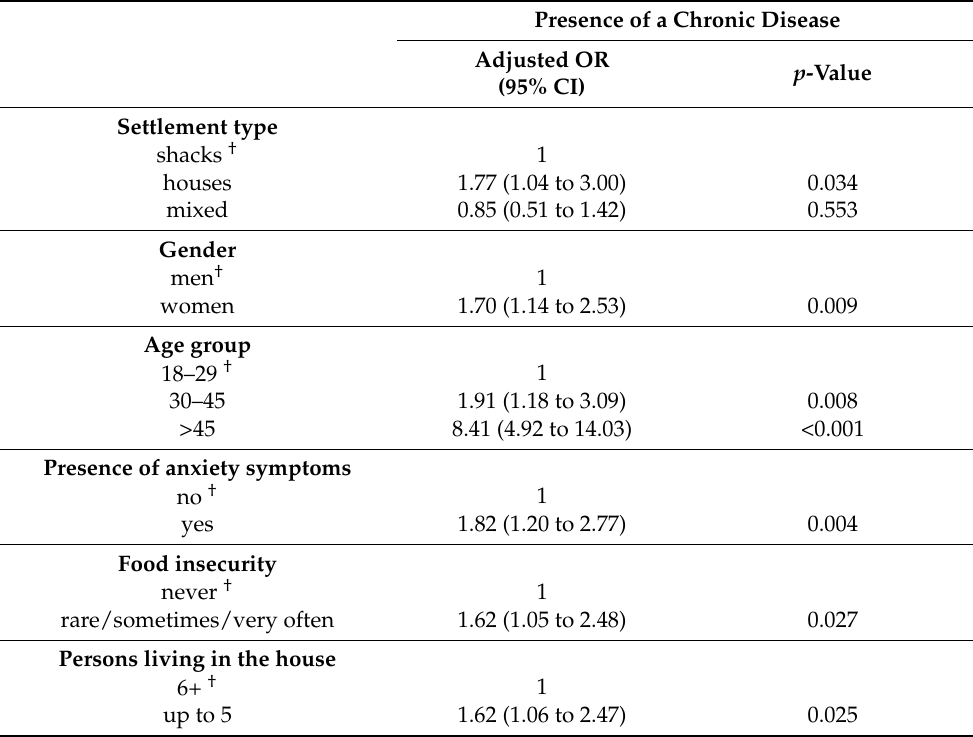
Table 4. Factors associated with the odds of the presence of a chronic disease of Roma living in Roma settlements in Greece: Results from multivariable logistic regression.